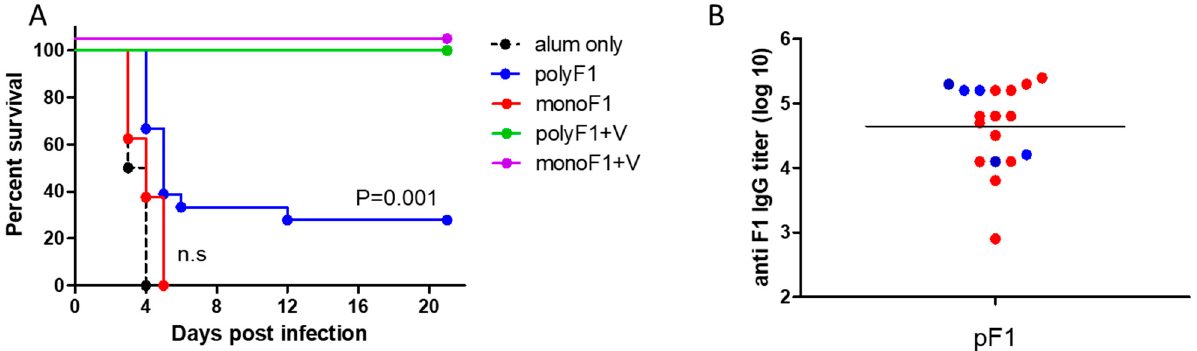
Figure 4. Longevity of the serological response following a single vaccination with monomeric F1 and polymeric F1 either alone or with LcrV. ( A ) Anti-F1 IgG titers measured in the sera of CD-1 female mice 180 days post a single vaccination with polymeric F1 (pF1, 80 µg/mouse), polymeric F1 + LcrV (pF1 + V, 80 µg each/mouse), monomeric F1 (mF1, 80 µg/mouse), and monomeric F1 + LcrV (mF1 + V, 80 µg each/mouse). ( B ) Anti-LcrV IgG titers that were measured in the sera of the mice as described in ( A ). The dashed horizontal line marks the limit of detection. n.s. = nonsignificant, * = p < 0.05, *** = p < 0.001.